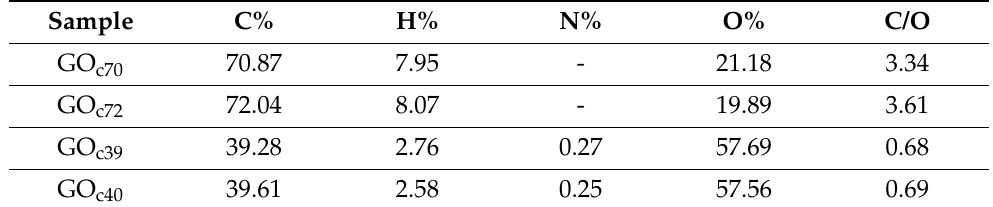
Table 1. Elemental analysis of GO